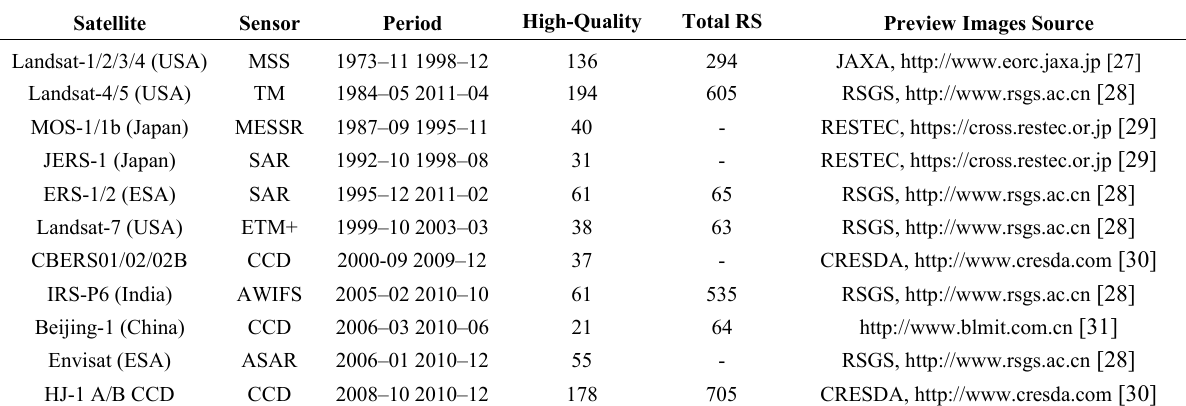
Table 1. Summary of common satellite preview images. MOS, Marine Observation Satellite; JERS, Japanese Earth Resources Satellite; ERS, European Remote-Sensing Satellite; ESA, European Space Agency; CBERS, China-Brazil Earth Resources Satellite; IRS, Indian Remote-Sensing Satellite; CCD, Charge Coupled Device; MSS, Multispectral Scanner System; TM, Thematic Mapper; MESSR, Multispectral Electronic Self-Scanning Radiometer; SAR, Synthetic Aperture Radar; ETM+, Enhanced Thematic Mapper Plus; AWiFS, Advanced Wide-Field Sensor; ASAR, Advanced Synthetic Aperture Radar; CRESDA, Center for Resource Satellite Data and